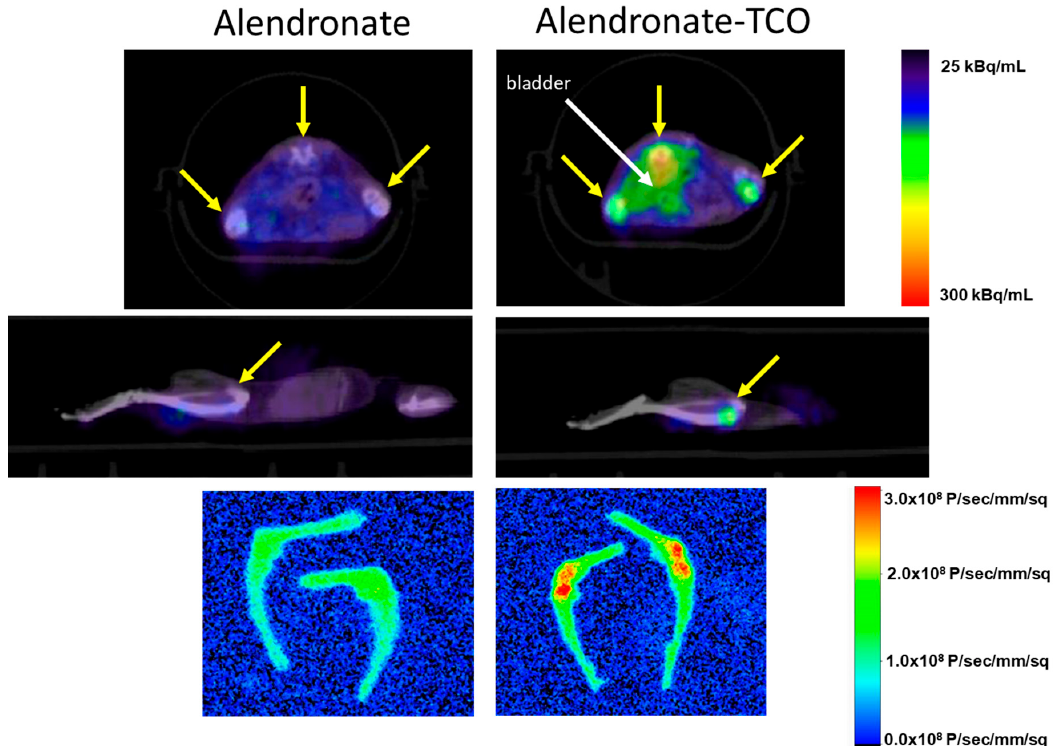
Figure 5. Imaging of 68 Ga-labeled IRDdye800CW-FSC-(PEG 5 -Tz) 2 in mice receiving alendronate alone (left row) or alendronate-TCO (right), PET / CT images: transverse slices (top) and sagittal slices (middle), yellow arrows indicate uptake in joints and spine, white arrow indicates the bladder. Bottom image: Optical image of excised bones of the lower limbs. Both PET and OI indicate higher accumulation in bone of alendronate-TCO pre-treated mice as compared to controls.